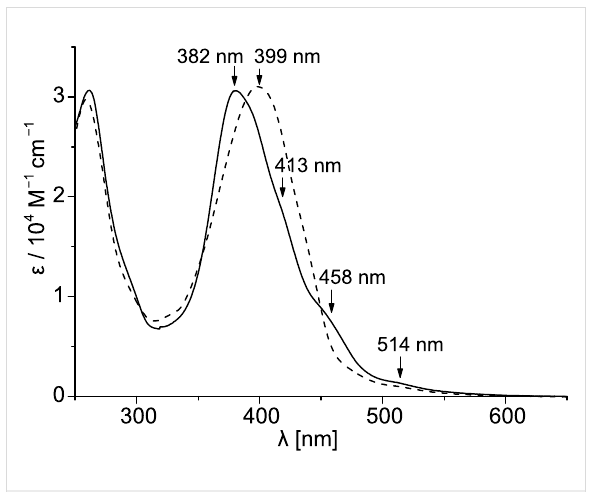
Figure 3: UV-vis spectra of T1 (concentration 5 x 10 − 5 M) in cyclo- hexane (solid line) and 2.4% MeOH in cyclohexane (dashed line) at 25